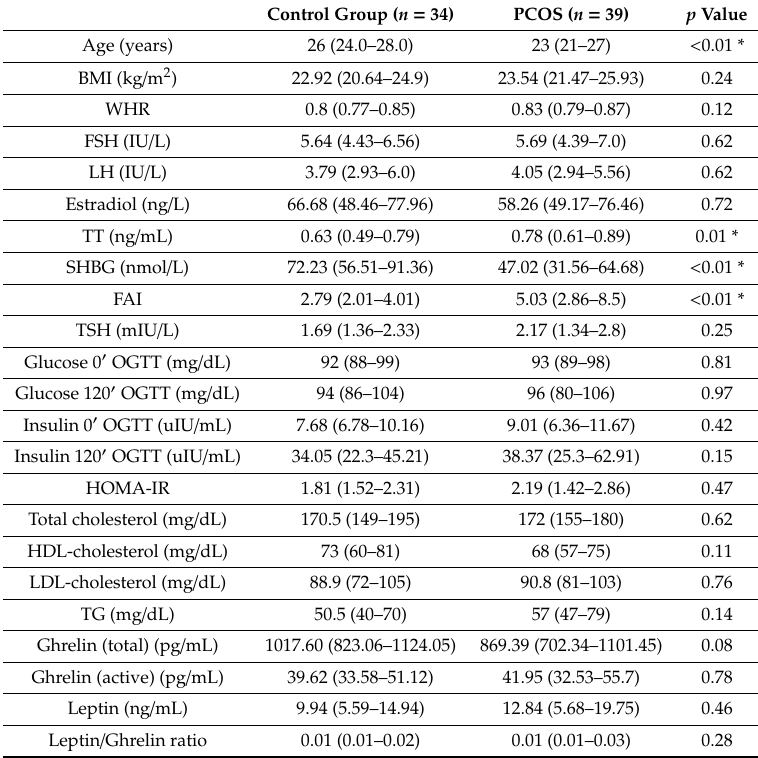
Table 1. Clinical and biochemical characteristics of the studied